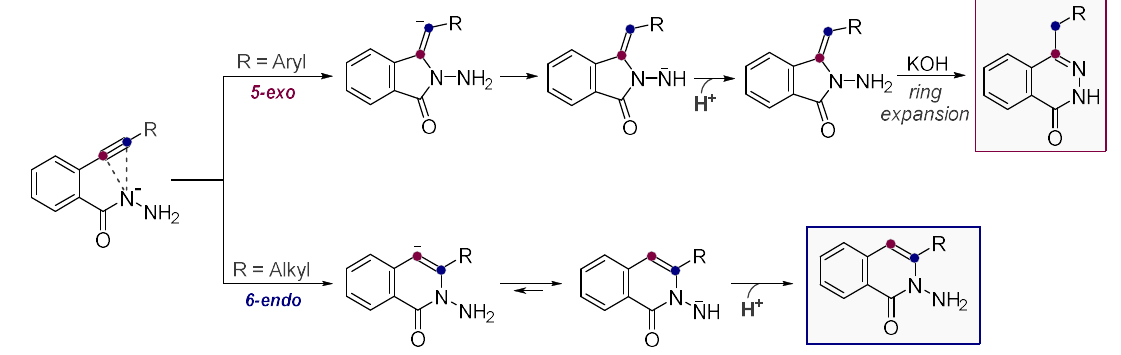
Scheme 18. Top: The cyclization of o-carboxy acetylenes, formed via cuprate addition, prefers the 5- exo-dig pathway. Bottom: Regioselective 6-endo-dig cyclizations of acetylenic carboxylates at five- membered